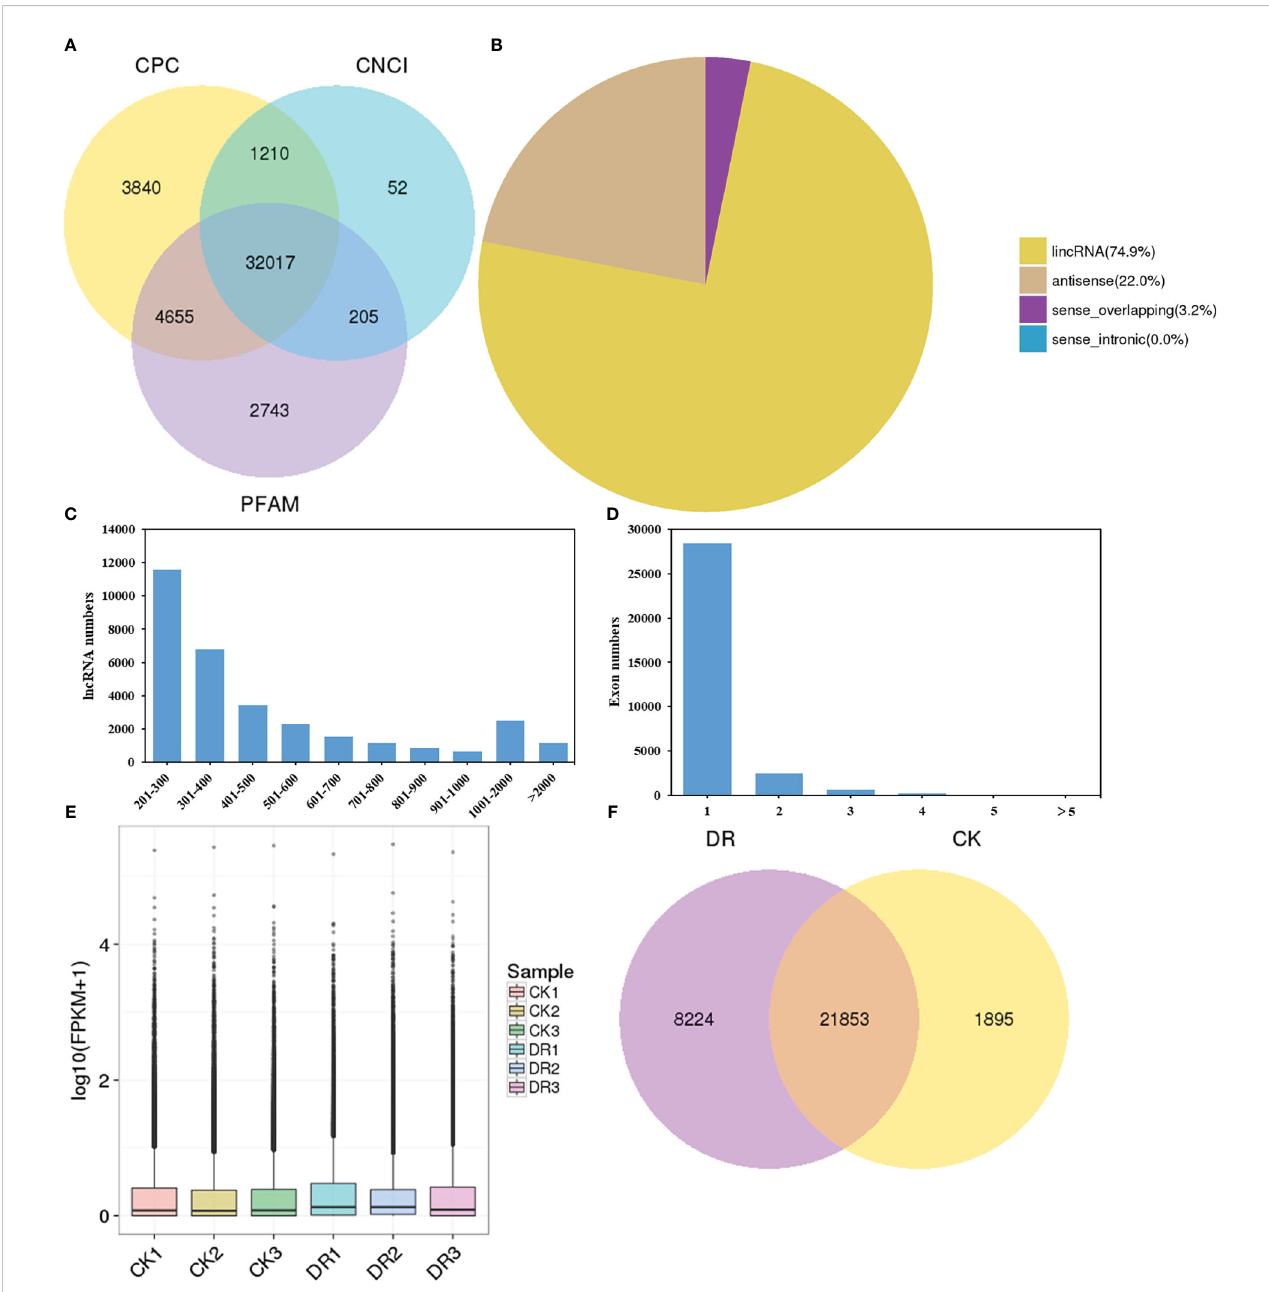
FIGURE 2 Prime features of lncRNA. (A) Venn diagram plot based on CPC, PFAM, and CNCI analyses. (B) Diagram showing lncRNA categories. (C) lncRNA length distribution. (D) Distribution of exon numbers in lncRNAs. (E) lncRNAs levels. (F) Venn diagram presenting shared and unique lncRNAs under CK and DR